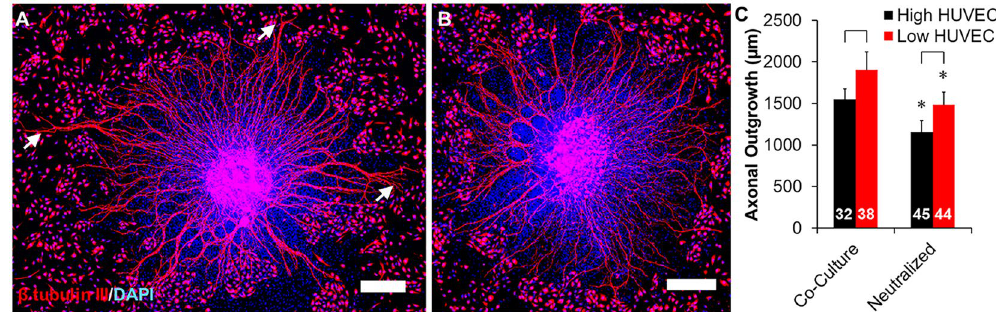
Figure 6. Neutralization of BDNF reduces DRG axonal growth in direct co-culture with HUVECs. DRG explants were cultured on ( A ) HUVECs and ( B ) HUVEC cultures supplemented with 125 ng/mL of BDNF neutralizing antibody. DRG-HUVEC co-cultures without neutralizing antibody displayed asymmetrical growth patterns, with long axons growing towards clusters of HUVECs (arrows). Supplementation of cultures with neutralizing antibodies restored symmetrical growth patterns. Scale = 200 µ m. ( C ) Quantification of DRG axonal outgrowth from explants cultured with high or low density of HUVECs and with or without BDNF neutralizing antibodies. Neutralization of BDNF significantly reduced axonal outgrowth, while low density seeding conditions supported more axonal outgrowth independent of the addition of the neutralizing antibody. Data are presented as mean ± standard error. Brackets (p < 0.001) indicate significance between HUVEC densities and *** (p < 0.001) indicate significance between cultures with and without neutralization antibodies as determined by two-tailed Student’s t-tests (DRG sample size for each group shown in bars from 4 independent replicates).